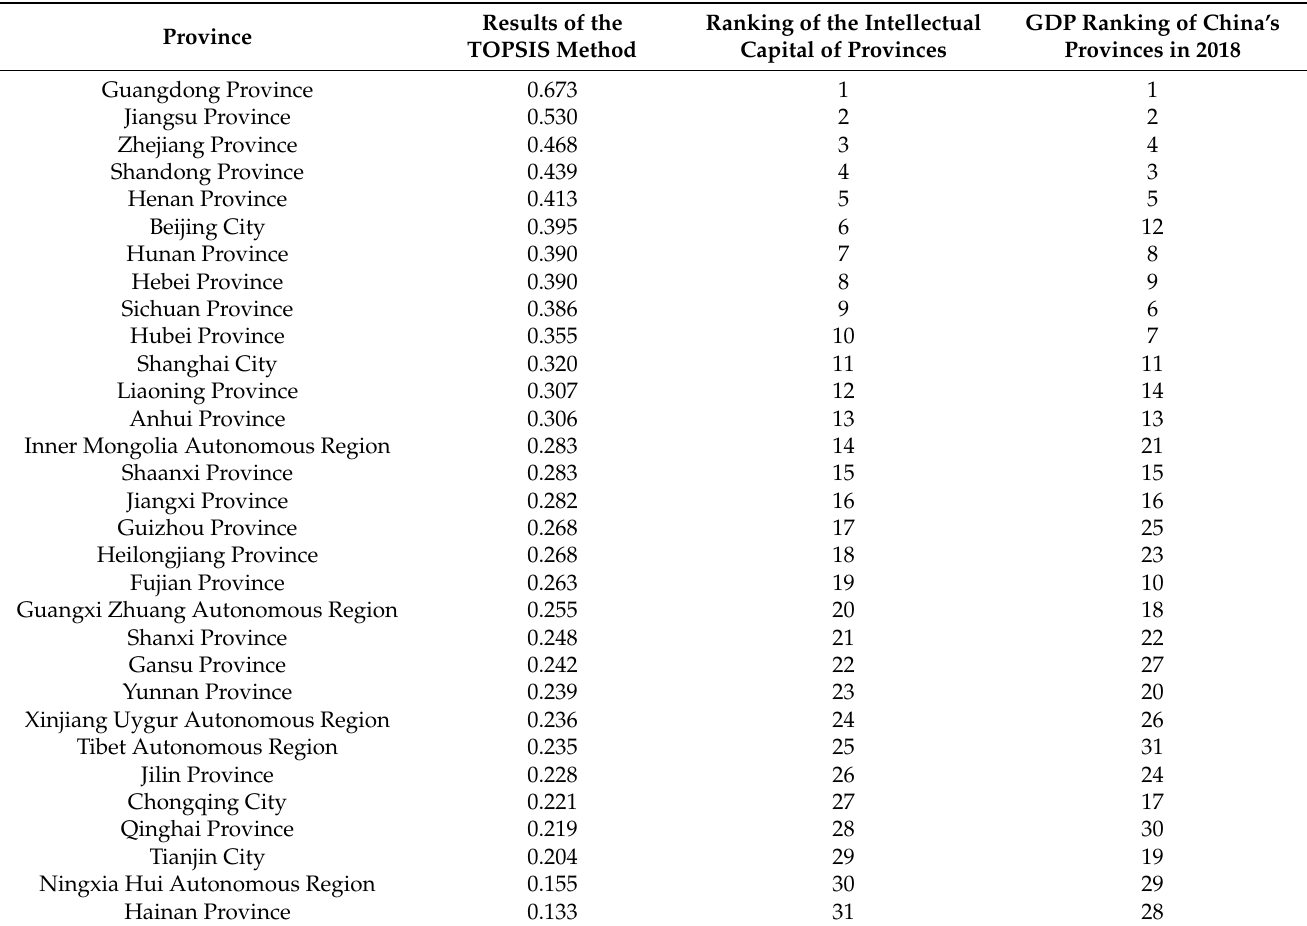
Table 8. Ranking of RIC and GDP of provinces in